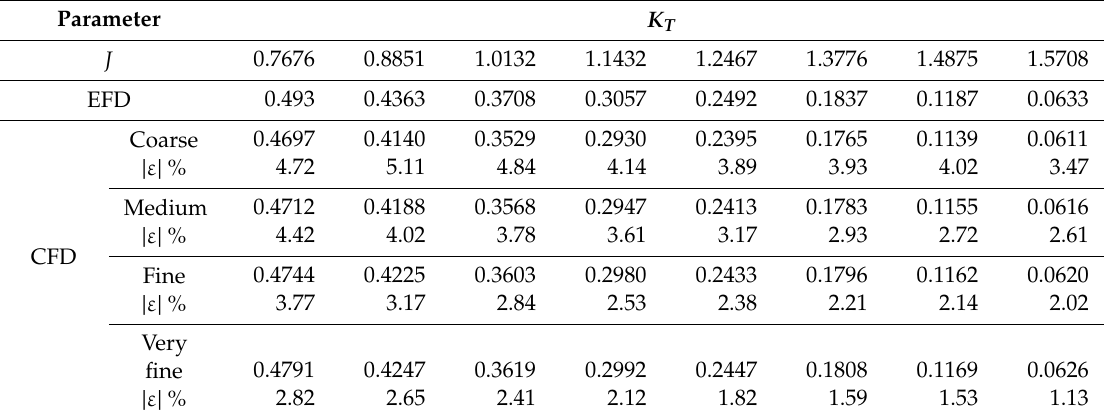
Table 7. Grid convergence test for the thrust coe ffi cient. Propeller working in cavitation tunnel.